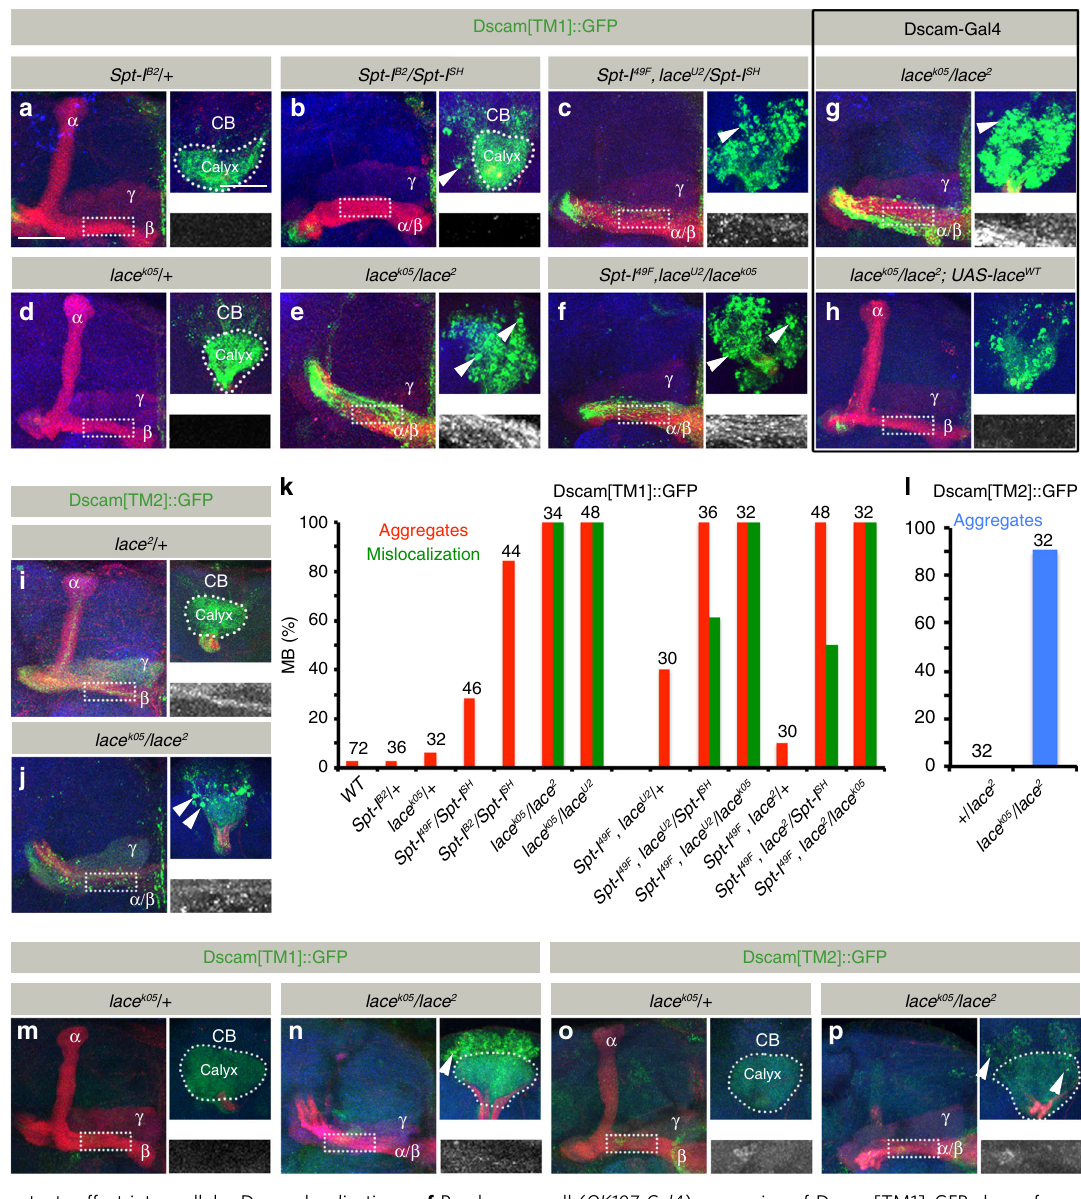
Fig. 3 SPT mutants affect intra-cellular Dscam localization. a – f Pan-kenyon cell ( OK107-Gal4) expression of Dscam[TM1]::GFP shows formation of aggregates in SPT mutants. While images a – f represent the axonal half of the MB, the corresponding somato-dendritic area of the same MB is represented in right upper insets. The white dotted rectangle represents the Dscam[TM1]::GFP distribution in the axons, zoomed in and shown in the right lower inset. While Spt-I trans-heterozygotes primarily show formation of Dscam[TM1]::GFP aggregates ( b , k ), an additional lace heterozygous mutation enhances the phenotype and leads to mislocalization of Dscam[TM1]::GFP into the axons ( c , k ). lace trans-heterozygous mutants are inherently stronger than Spt-I mutants and show a high penetrance of Dscam[TM1]::GFP aggregates and axonal mislocalization ( e , f , k ). g , h Like OK107-Gal4 , expression of Dscam [TM1]::GFP using Dscam-Gal4 shows formation of somatic aggregates and axonal mislocalization in lace trans-heterozygous mutants ( g ), which can be rescued by co-expressing a lace wild-type transgene ( h ). n ( g ) = 34, n ( h ) = 30. i , j Expression of Dscam[TM2]::GFP using 201Y-Gal4 also shows formation of somatic aggregates in lace trans-heterozygous background ( j , l ). k Percentage of MB showing somatic aggregates and axonal mislocalization of